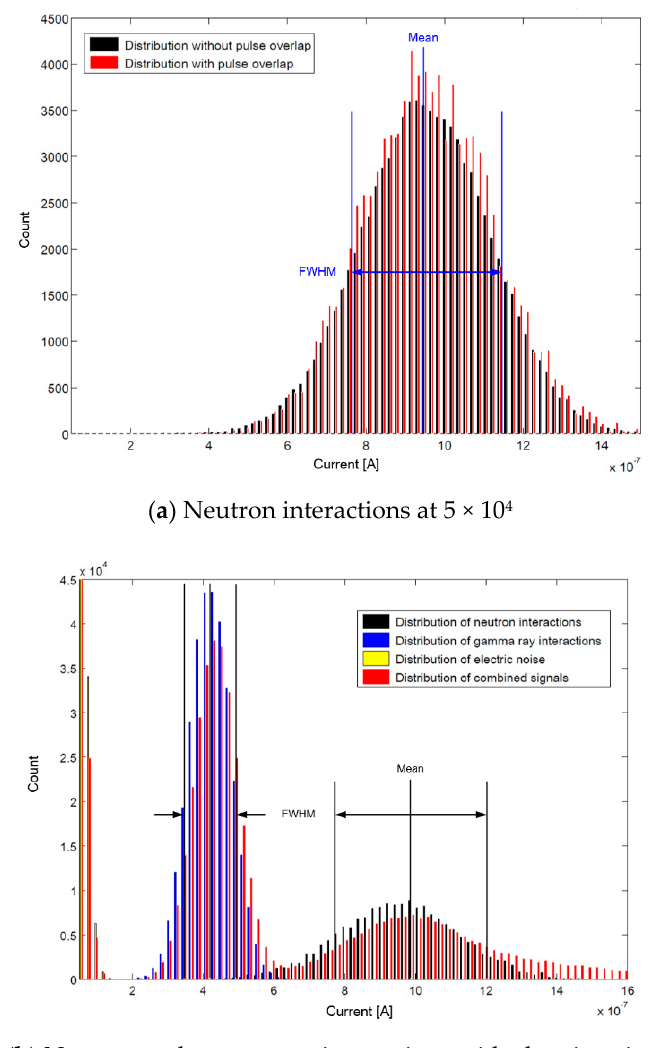
Figure 5. The pulse height distributions.